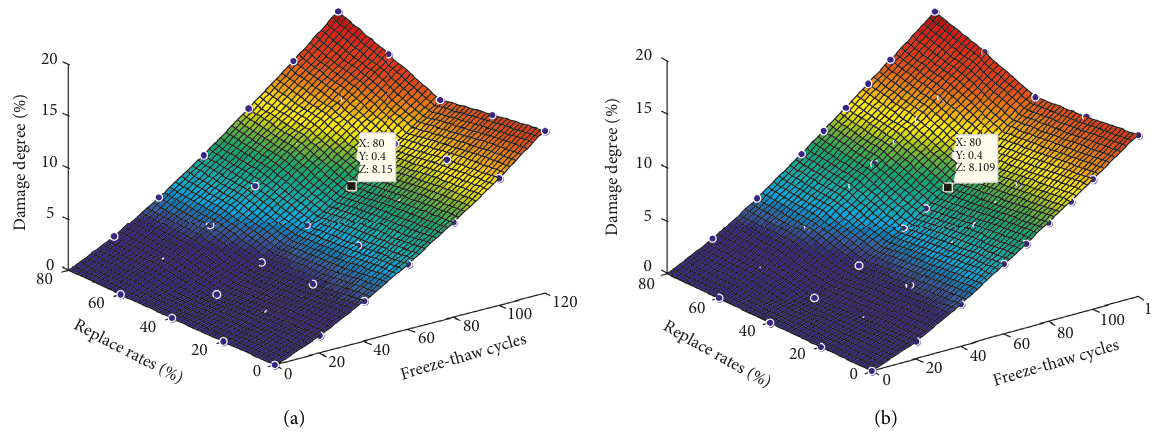
Figure 8: Evolution of freeze-thaw damage with different replace rates. (a) Experimental value of damage degree. (b) Simulation value calculated by proposed damage